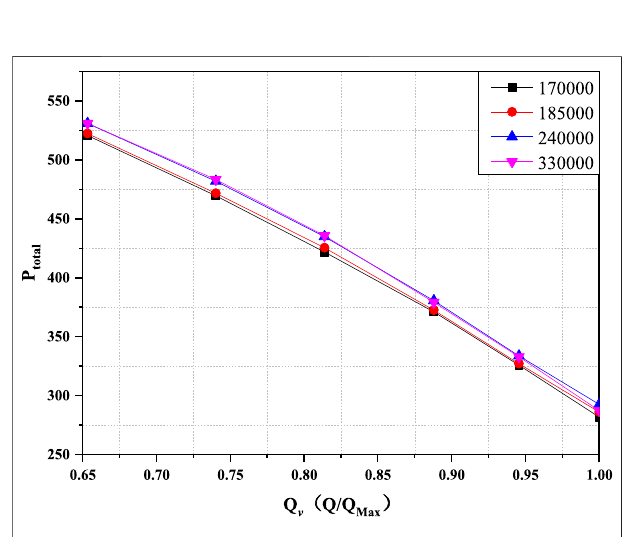
FIGURE 4 | Veri fi cation of grid independence.